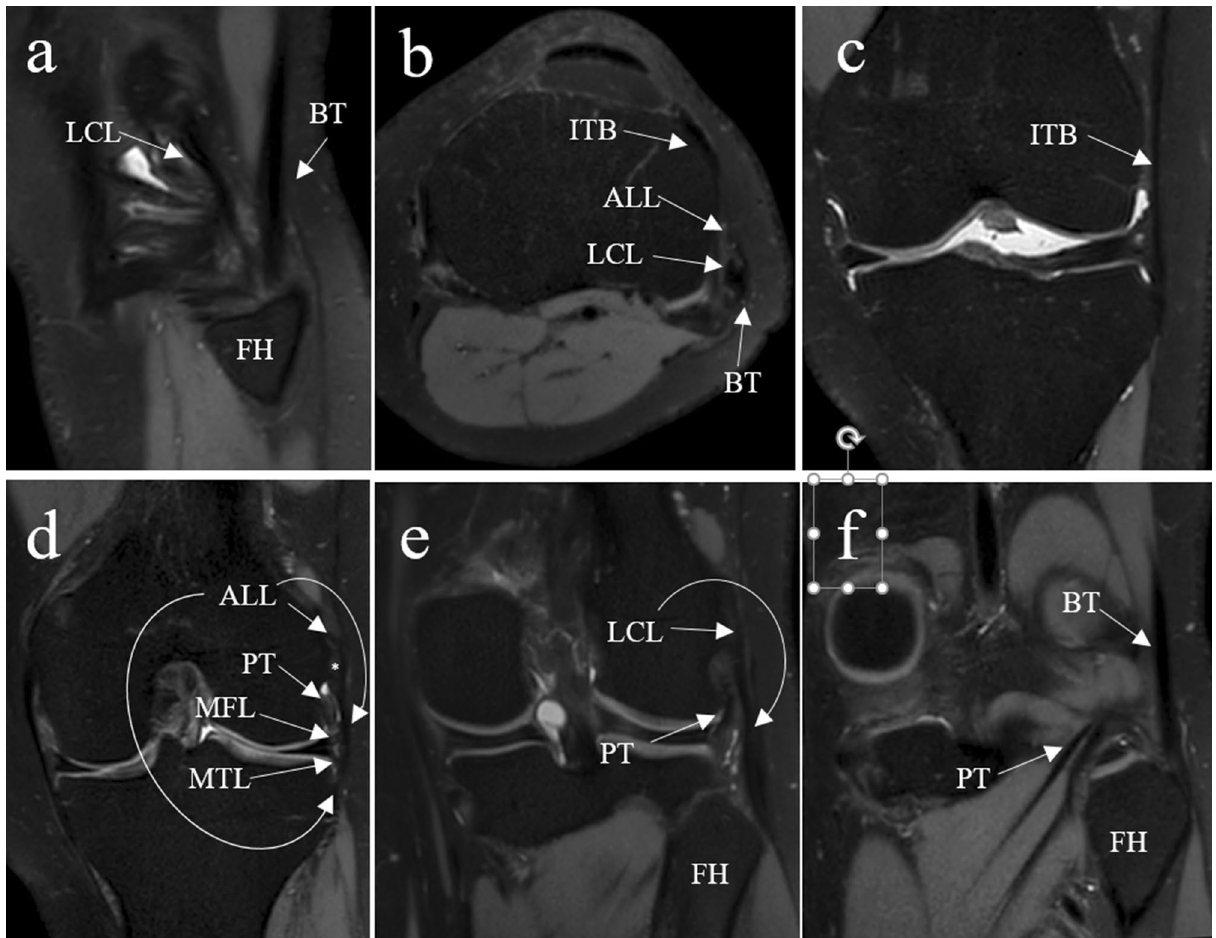
Figure 1. The anterolateral structures are shown in different MRI planes. ( a ) Represents a sagittal MRI image with the lateral collateral ligament (LCL) and the biceps tendon (BT) inserting at the fibular head (FH). ( b ) An axial image that displays the insertion of the iliotibial band (ITB) at Gerdy’s tubercle as well as the anterolateral ligament (ALL), LCL and BT. ( c ) Shows the course of the ITB in a coronal image. In image ( d ) the entire ALL with femoral, tibial and meniscal part is marked as well as the popliteus tendon (PT) and the meniscofemoral (MFL) and meniscotibial ligament (MTL). In this image the lateral epicondyle with the merging fibers of ALL, LCL and MFL is marked with an asterisk. Another coronal image further posterior shows the LCL and the PT ( e ), while in the last image ( f ) even further posterior the BT and PT are